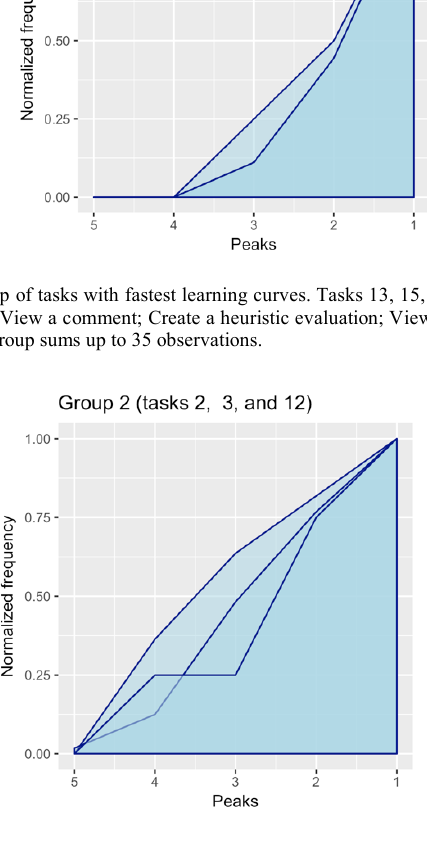
Fig. 9. Group combining learning curve for tasks 2 (Search for or filter topics), 3 (View content), and 12 (Reset password). This group sums up to 174 observations.